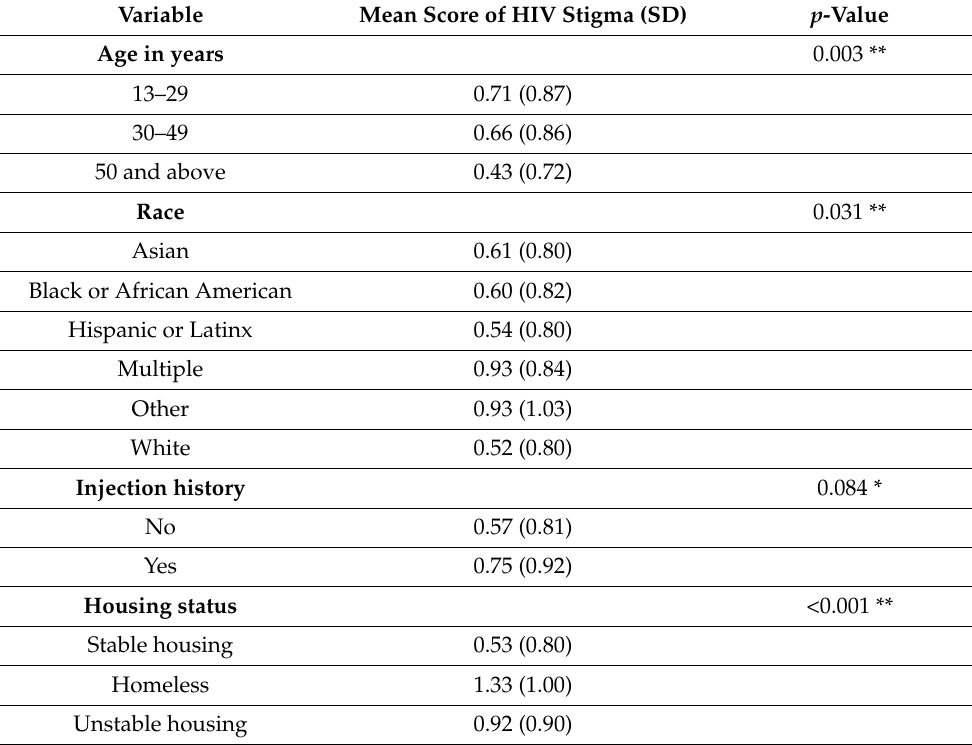
Table 2. Average HIV stigma score by individual